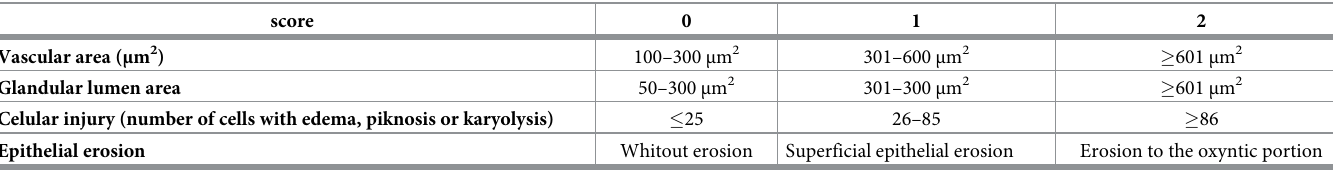
Table 1. Scale to indicate the score for each